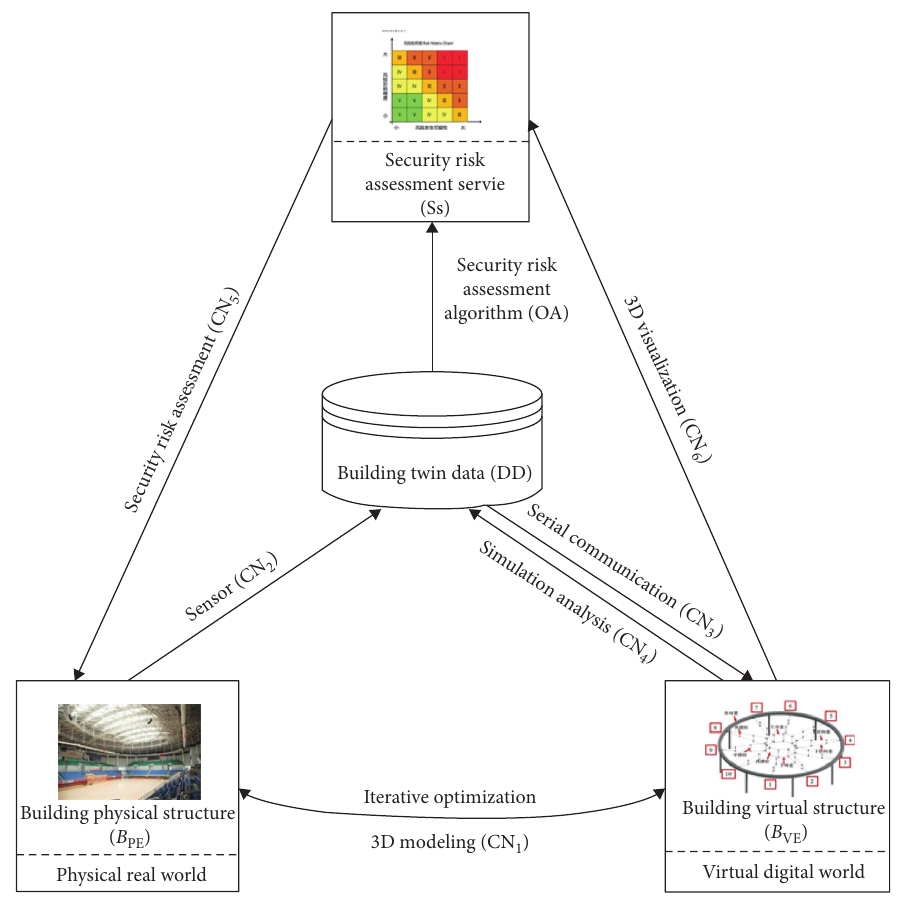
Figure 2: Digital twin-based security risk assessment